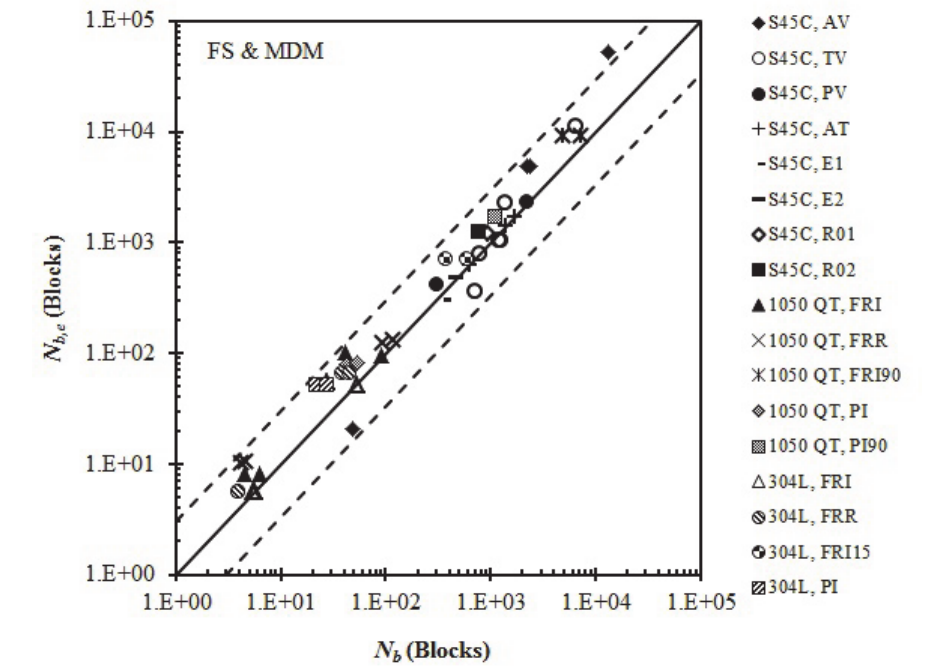
Figure 5: Comparison of observed and predicted fatigue lives by Procedure